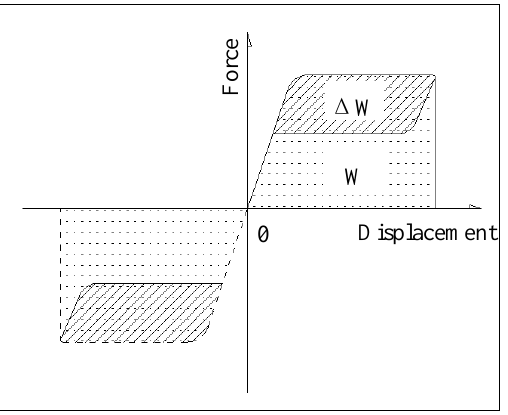
Figure 11 . Schematic diagram of dissipated energy and maximum potential energy.